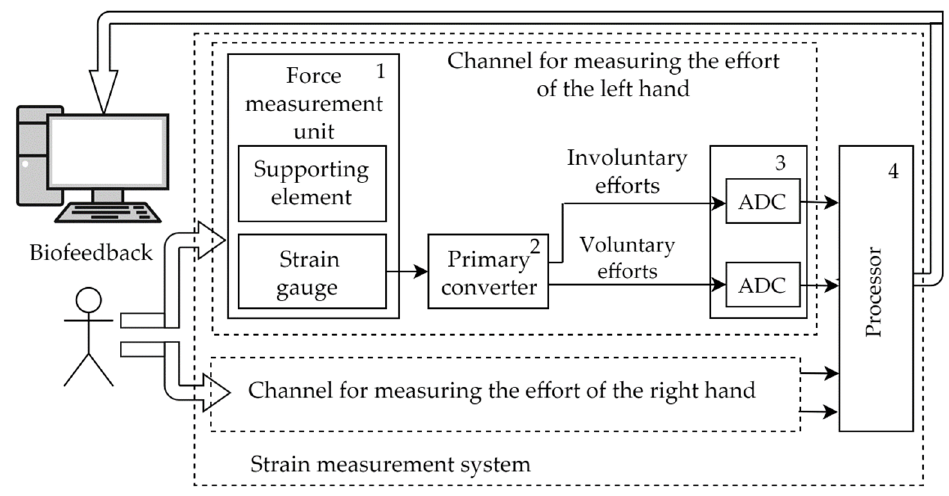
Figure 2. Structure of the strain gauge measuring system.